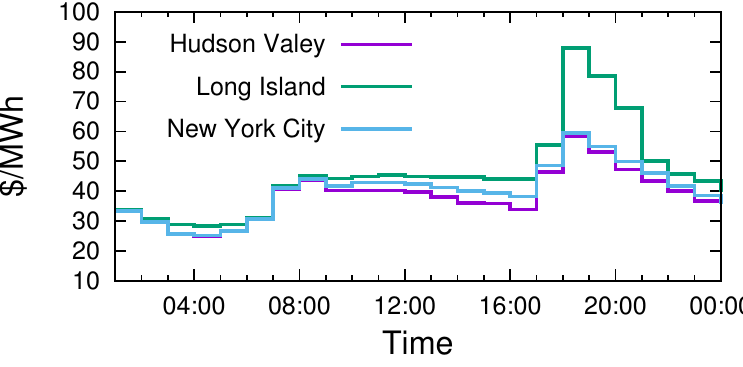
Figure 1. Hourly electricity prices for Hudson Valley, Long Island and New York City on 1 December 2011